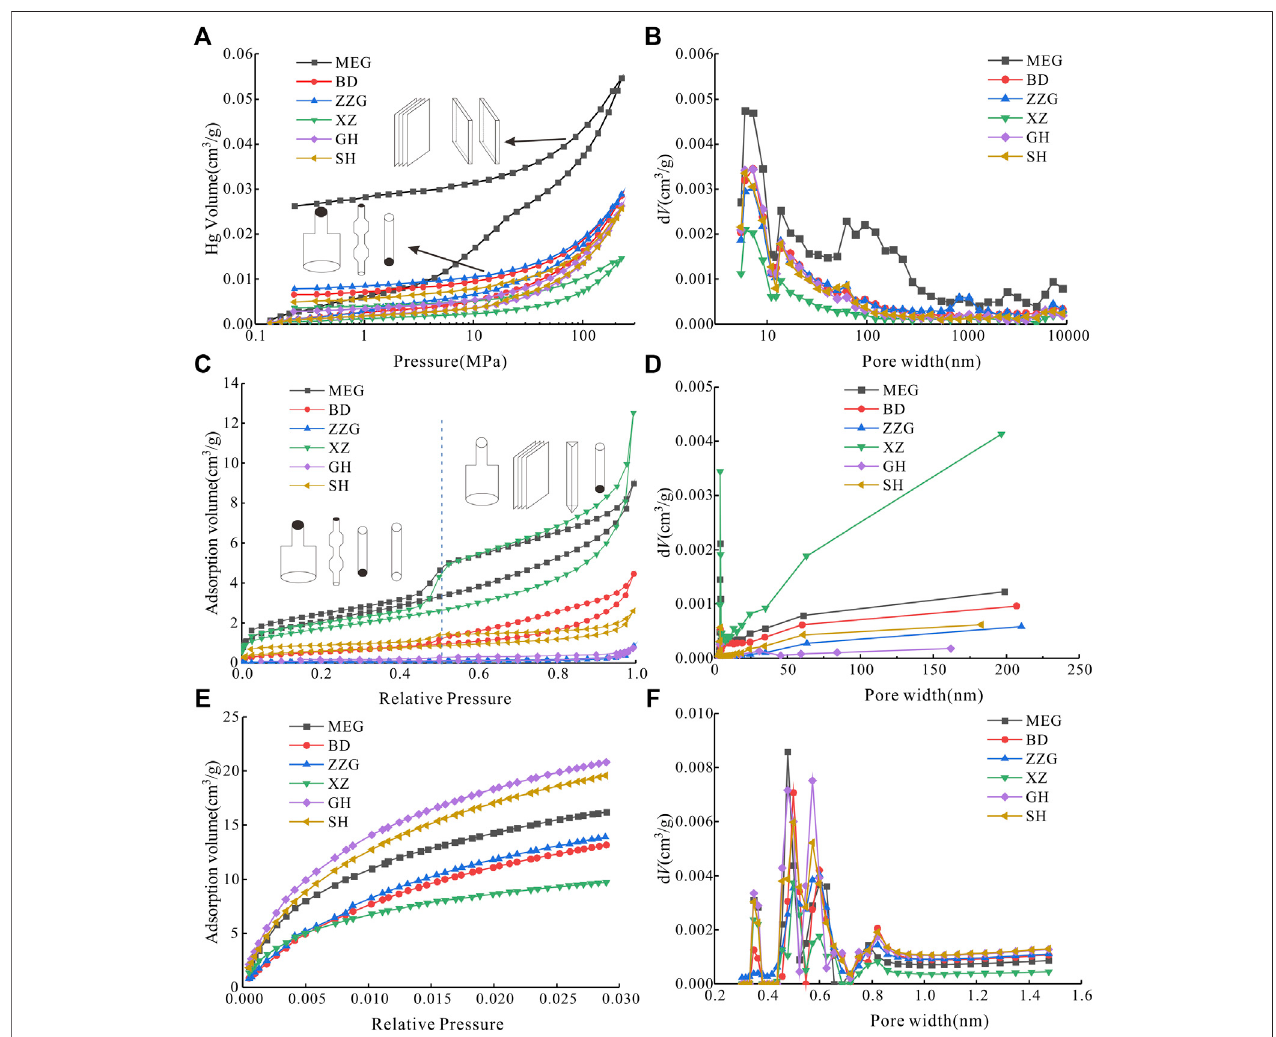
FIGURE 2 | Pore size distribution characteristics of different test methods (A) . Characteristics of mercury Intrusion-Extrusion curve; (B) . Pore distribution characteristics of HPMI; (C) . Adsorption-desorption curve characteristics of LT-N 2 A; (D) . Pore distribution characteristics of LT-N 2 A; (E) . Isothermal adsorption curve characteristics of LP-CDA; (F) . Pore distribution characteristics of